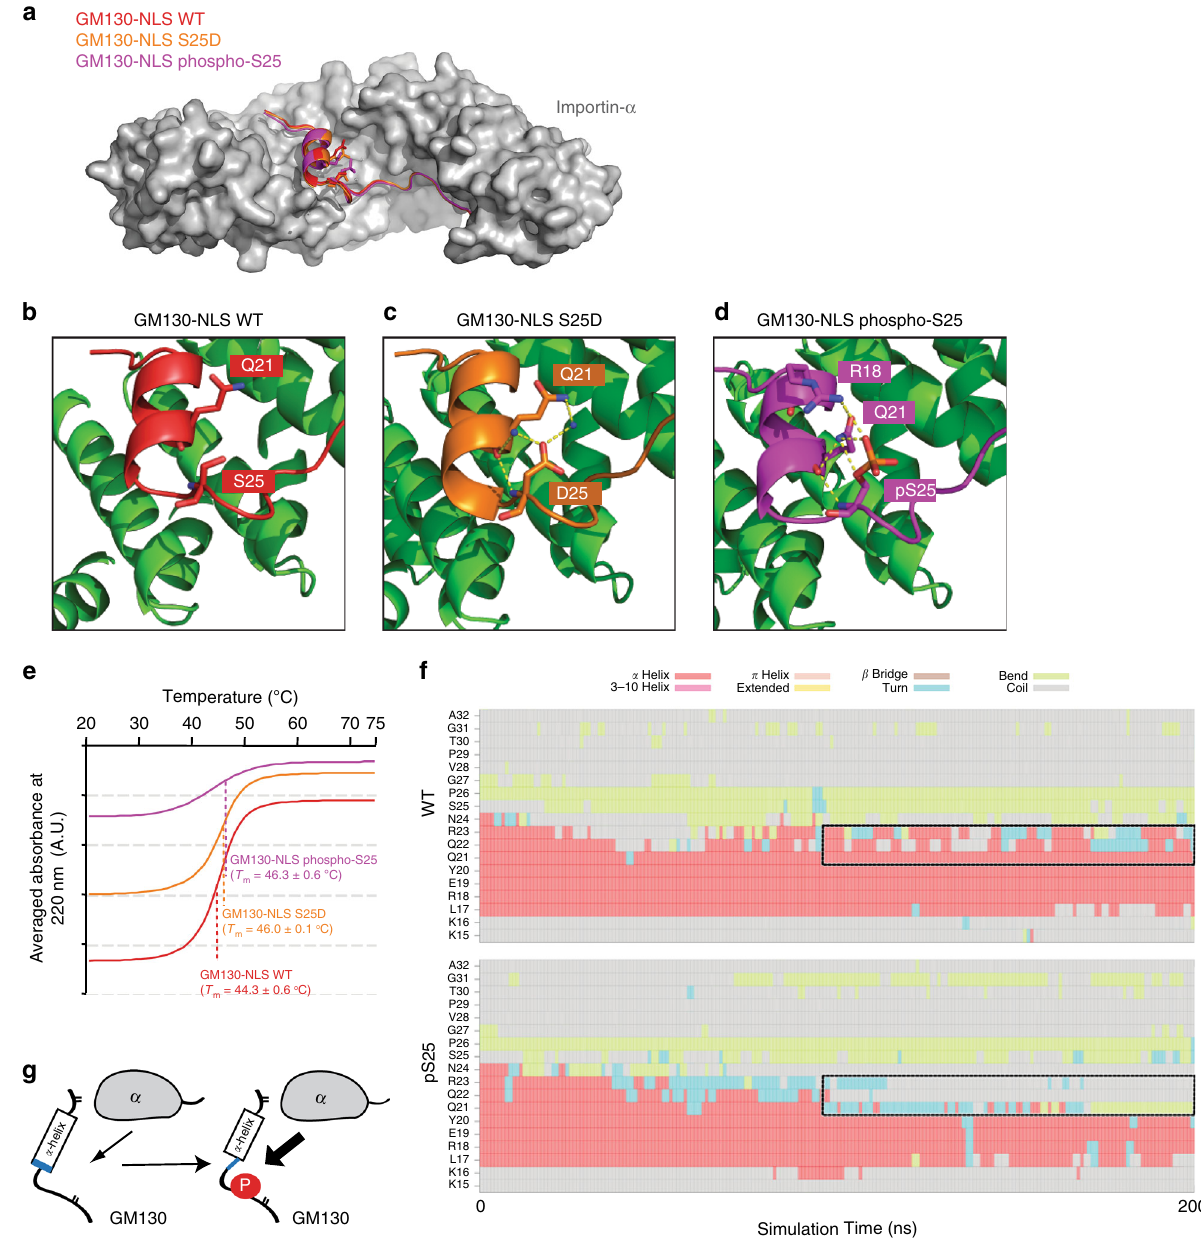
Fig. 2 A phosphate moiety mediates GM130 intra-molecular interactions. a Superimposition of the GM130-NLS WT (red), GM130-NLS S25D (orange) and GM130-NLS phospho-S25 (purple) crystal structures. Importin- α (a.a. 70 – 498) is shown in gray. b – d Detailed views of the residue-residue interactions mediated by Serine-25 ( b ), Aspartic acid-25 ( c ), or Phosphoserine-25 ( d ) in GM130. Water molecules are shown as blue spheres. Hydrogen bonds are indicated by dotted lines. e Circular dichroism spectra of temperature scans at a wavelength of 222 nm for GM130-WT (red line), S25D (orange line) or phosphor-S25 (purple line) complexes. Each complex spectrum represents the average of three scans. The melting temperature ( T m ) of each complex is indicated. f Mean secondary structure of GM130-NLS residues 15 − 32 (averaged over eight 200-ns simulations) in solution as a function of simulation time for native peptide (top) and phosphorylated peptide (bottom). g Schematic model of how phosphorylation on GM130-NLS disrupts the α -helix in apo state, enhancing Importin- α